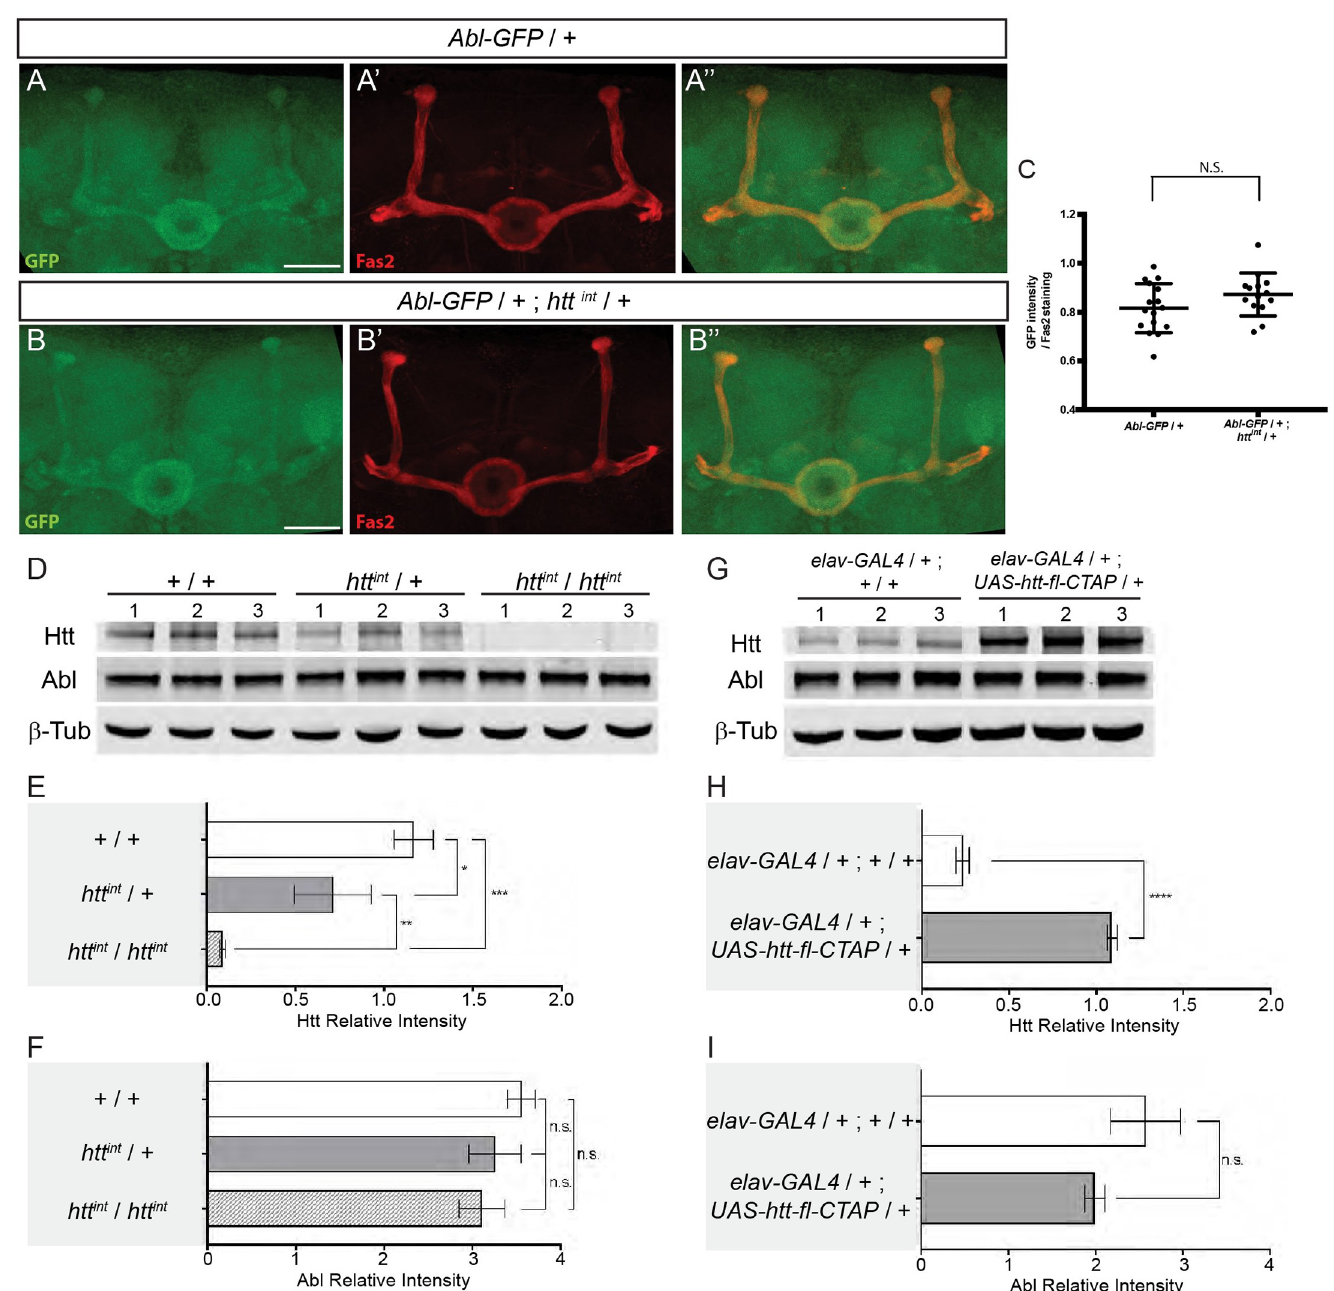
Fig 6. htt does not seem to affect the quantity of ABL in the MBs or the total levels of neuronal Abl in Drosophila . (A-B”) Expression of the Abl-GFP genomic transgene in a WT (A) and in a htt int heterozygous mutant background (B) at 48 hAPF. Anti-Fas2 staining marked αβ neurons (A’-B’). Merge of GFP and anti-Fas2 staining (A”-B”). Note that panels A-A” are also presented in Fig 3J–3J”. (C) Quantitation of the GFP expression within MBs is not significantly different (N.S.) between WT and htt int heterozygous mutant background using a Mann-Whitney U test. The scale bar indicates 30 μ m. Details of image quantification procedure and full genotypes are: (C) After having outlined the MB with the Fas2 staining, GFP and Fas2 intensities from MB shape were quantified for each slices of the stack. The GFP intensity of each slices was averaged and then normalized by the mean Fas2 intensity. Number of MB analyzed: control = 16, htt mutant = 14. Quantitation of the GFP expression within MBs is not significantly different between WT and htt int heterozygous mutant background using a Mann-Whitney U test. Quantitation were done with ImaJ software. Images are composite stacks to allow the visualization of axon trajectories along their entire length. Genotypes: (A) y w 67c23 ; Abl-GFP / + . (B) y w 67c23 ; Abl-GFP / +; htt int / + . (D) Western blots of whole cell lysates from adult heads from the following genotypes: + / +, htt int /+ and htt int /htt int . Levels of Htt, Abl, and β -Tubulin ( β -Tub) were assessed by probing blots using the indicated antibodies. 1, 2, and 3 indicate biological replicates for each line. (E and F) Quantitation of Htt (E) or Abl (F) protein levels in the indicated genotypes was assessed from western blots in (D) relative to β -Tubulin and plotted as relative band intensity. (G) Htt was over-expressed using elav c155 -GAL4 > UAS-htt-fl-CTAP . Lysates from adult heads were subjected to western blotting to assess Htt, Abl, and β -Tubulin levels. 1,